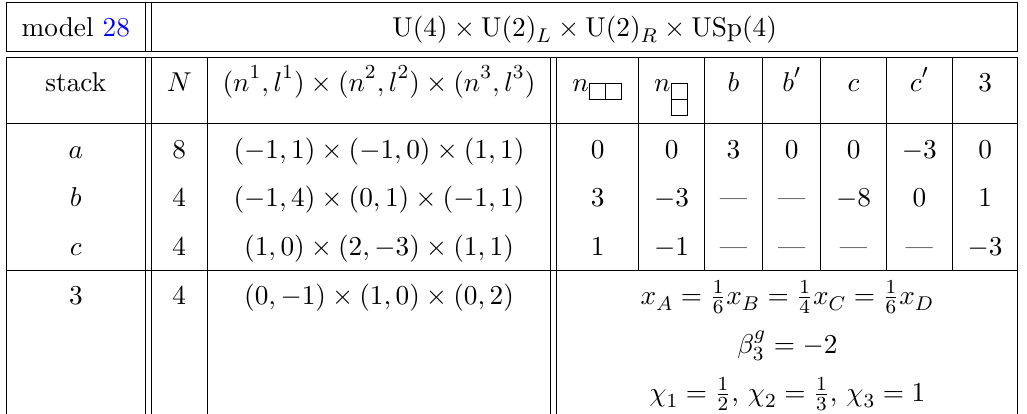
Table 28 . D6-brane configurations and intersection numbers of Model 28, and its MSSM gauge